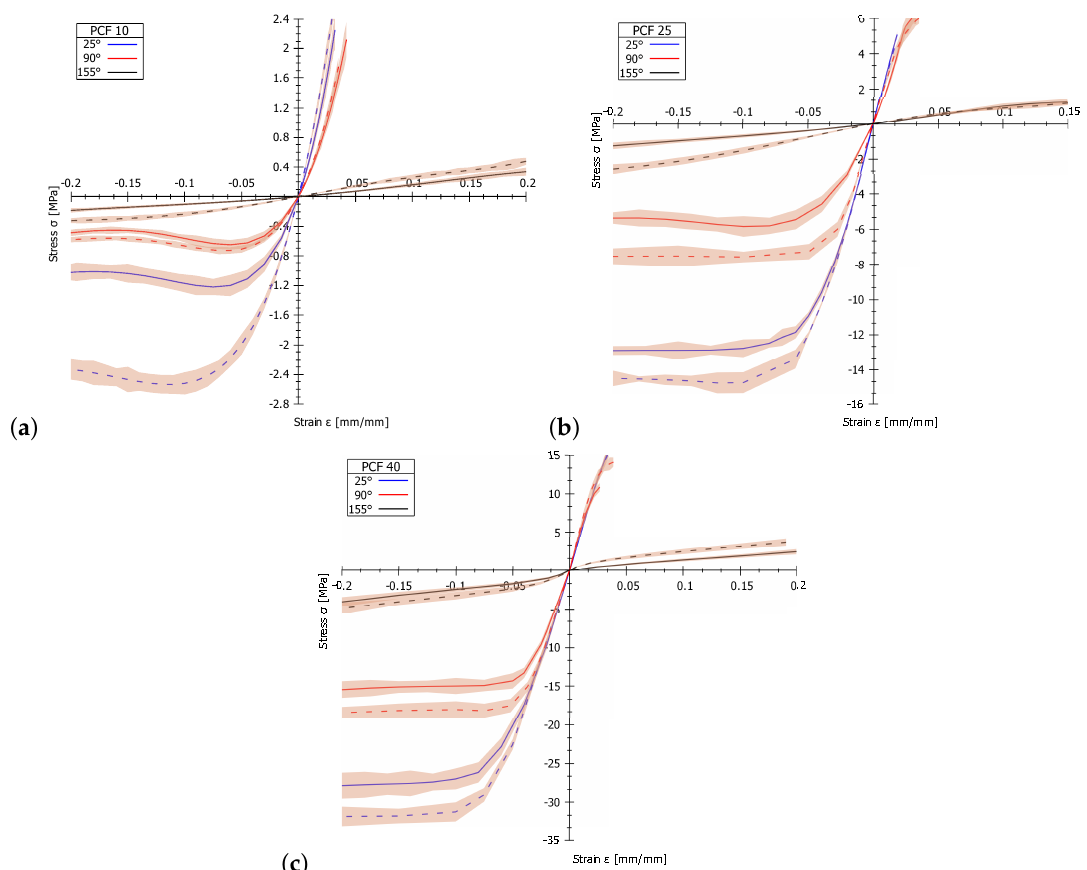
Figure 4. Stress–strain curves for tension and compression test of all analysed PUR foams: ( a ) PUR foam PCF 10, ( b ) PUR foam PCF 25 and ( c ) PUR foam PCF 40. Strain rate of 4.5 mm/min is the full lines, and strain rate of 45 mm/min is the dashed lines. The gray area is the range of the variance of the values.